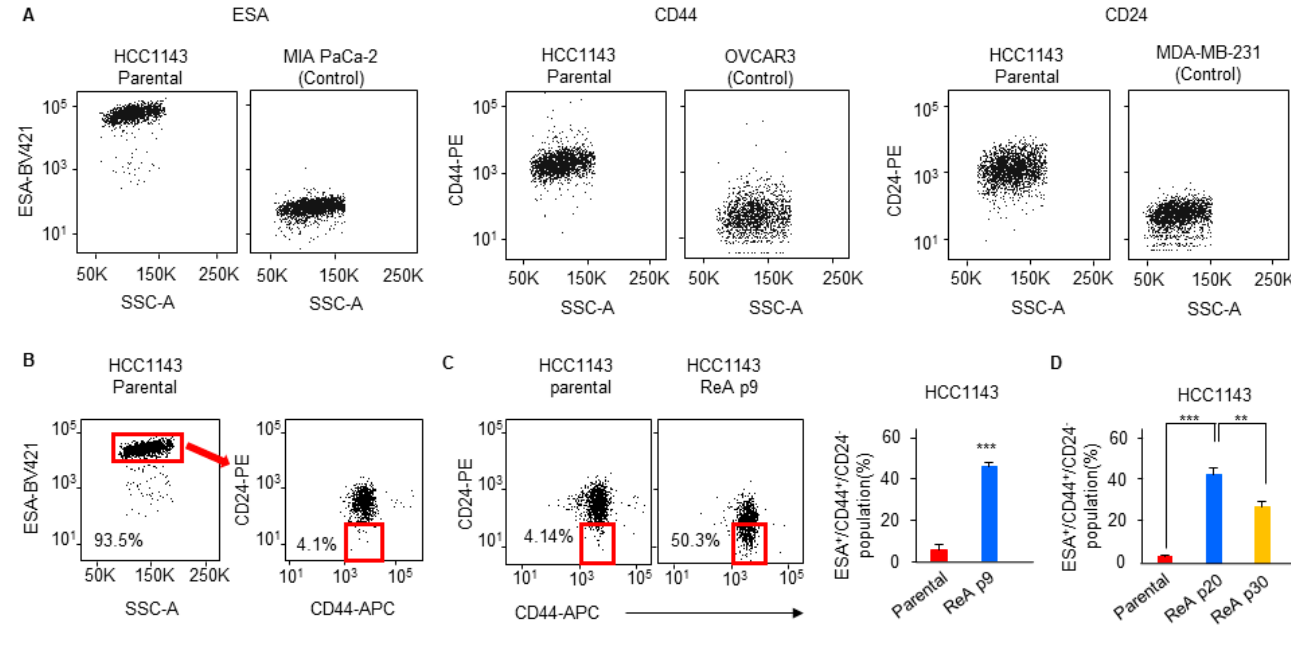
Figure 2. The ReA cell population exhibits an increased proportion of ESA + CD44 + CD24 − cells. ( A ) Flow cytometry analysis to optimize conditions for identifying positive or negative cells for the three markers (ESA, CD44, and CD24). ( B ) The ESA + population was gated, and the CD44 + CD24 − population was examined in HCC1143 parental cells. ( C , D ) The proportion of ESA + CD44 + CD24 − population in ReA cells by passage was examined and quantified using flow cytometry. Values are represented as the mean ± standard deviation of three independent experiments. ** p < 0.01, *** p < 0.001 relative to parental cells.